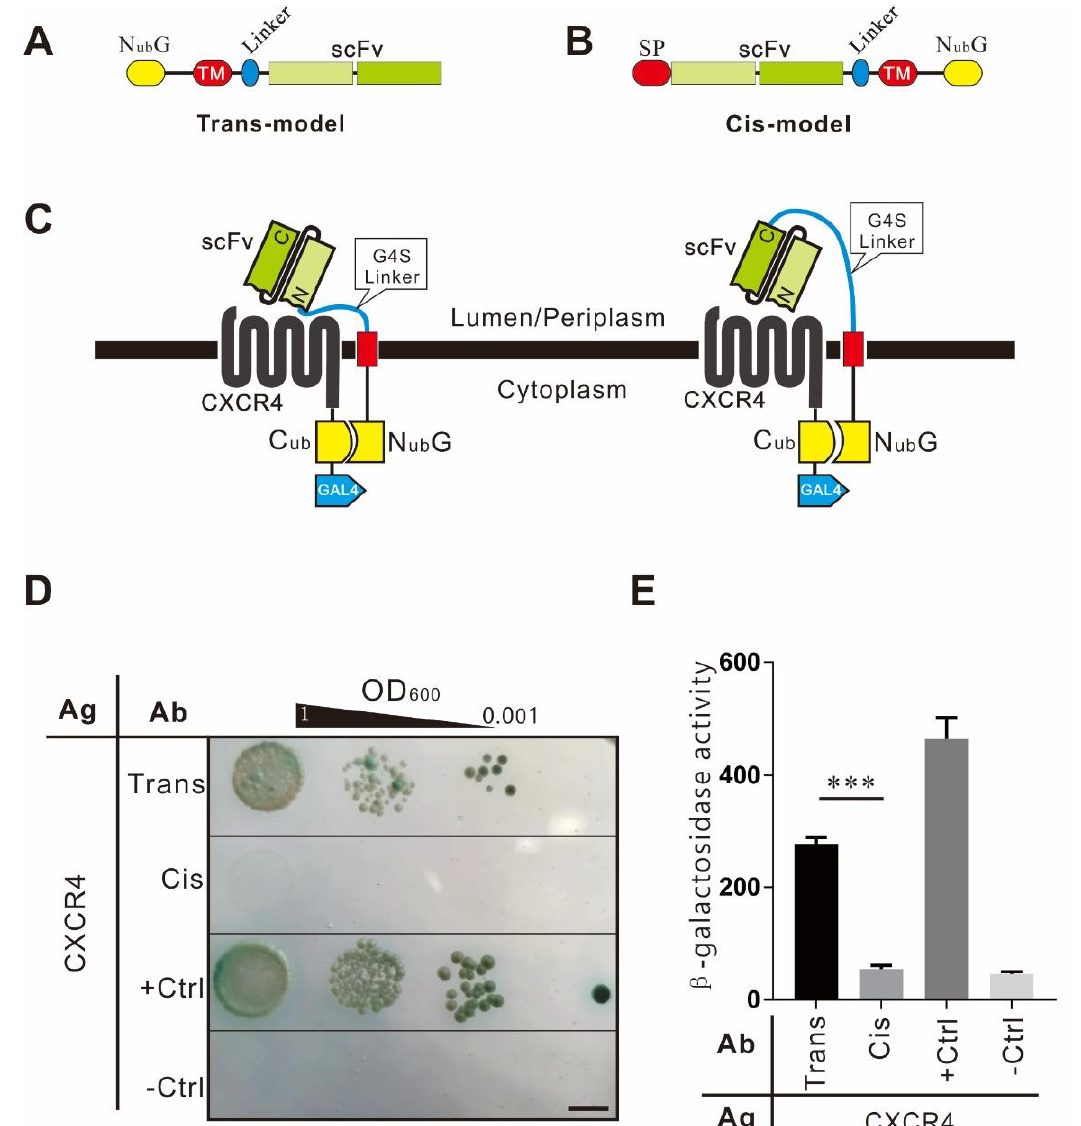
Figure 2. Optimization of antibody modules with different topological structures. ( A ) The trans -structure. The N ub G domain is fused with a type II transmembrane peptide (the C-terminus is outside of cytomembrane and the N-terminus is in the cytoplasm), followed by a linker and an scFv in tandem. ( B ) The cis structure. The scFv is fused with an α signal peptide at its N-terminus and a type I transmembrane peptide at the C-terminus (the N-terminus is secreted out of cytomembrane, and the C-terminus remains in the cytoplasm), followed by N ub G in tandem. ( C ) Diagram of interactions between G-protein-coupled receptor (GPCR) and scFv with two types of topological structures. ( D ) Cell growth assay. AH109 cells expressing the antigen module CXCR4-C ub -GAL4 and Y187 cells displaying the scFv module with the trans or cis topological structure were hybridized and plated onto SD/Leu − Trp − Ade − His − plates containing X- α -gal. The growth of diploid cells was observed after 72 h cultivation. CXCR4-C ub -GAL4 × TM pho -N ub G was used as a negative control, and CXCR4-C ub -GAL4 × TM pho -N ub I was used as a positive control. Ag: antigen. Ab: antibody, the bar indicates 5 mm. ( E ) Quantitative β -Gal assay of diploid cells expressing CXCR4-C ub -GAL4 and two types of topological structure fusion proteins. The positive and negative controls were the same as in Figure 2D. The experiment was repeated three times independently, and every sample was tested in duplicate in each experiment ( n = 2), *** indicates p -value <